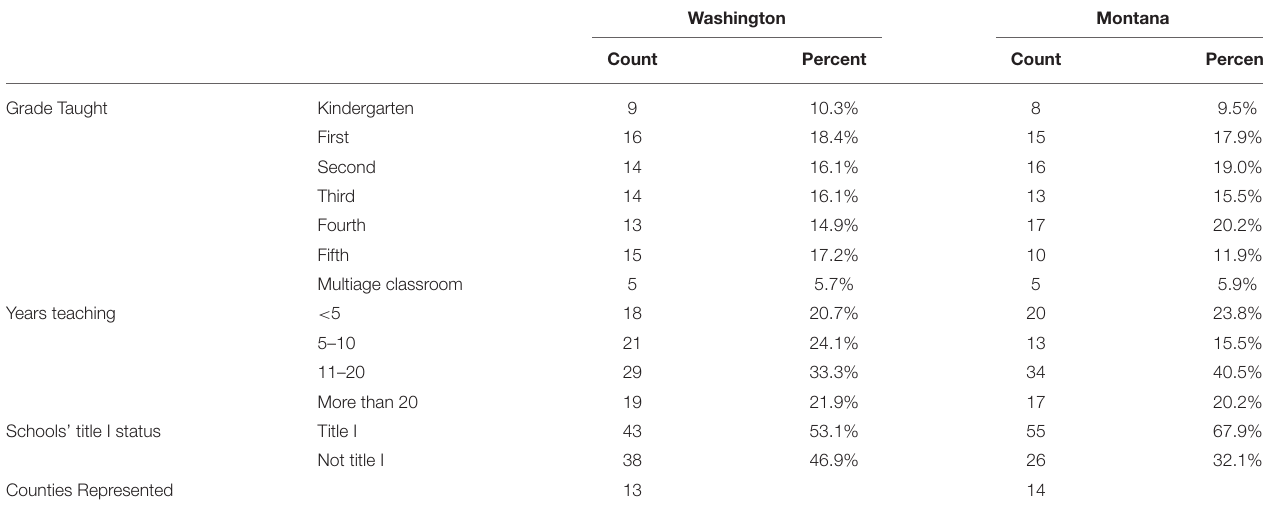
TABLE 1 | Demographic characteristics of participants from Washington and Montana. Percentages listed indicate the percent of respondents that completed all or part of the